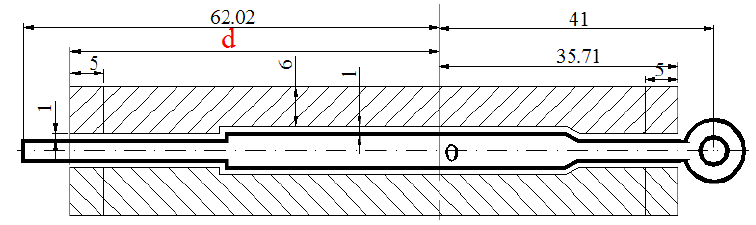
Figure 12. Detailed dimensions of baffle plates in the welding chamber (mm).